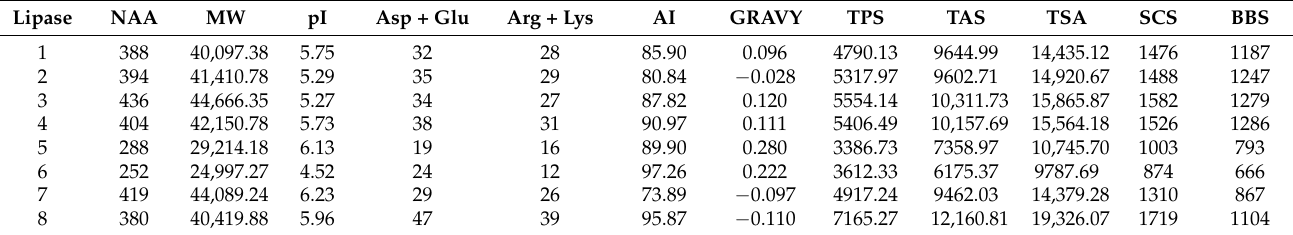
Table 1. Physiochemical and SASA features of Amycolatopsis eburnea lipases.